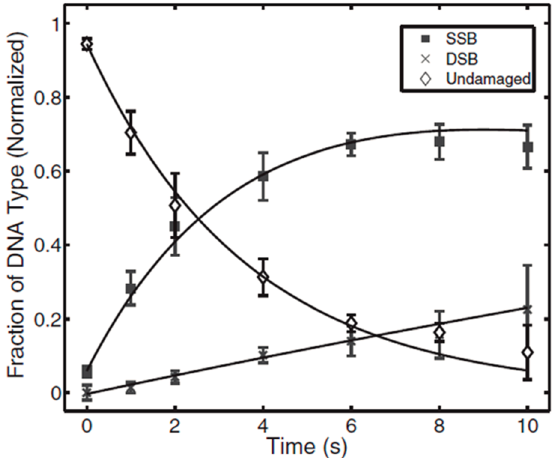
Figure 9. Representation of the relative abundances of three DNA conformers: supercoiled form-undamaged DNA, open circular form-SSB, and linear form-DSB in PBS solution treated by APP at various exposure times. Adapted from [52] with the permission of AIP Publishing LLC,